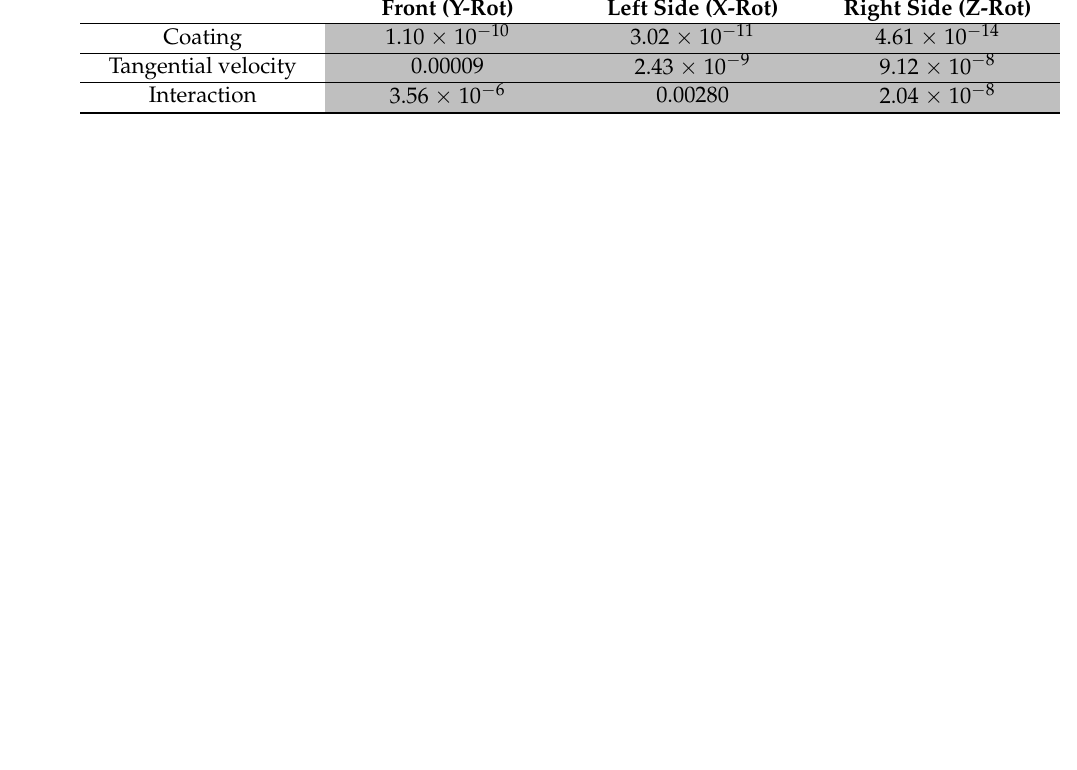
Table 8. Two-way ANOVA results ( p -values) for the PAA. p -values < 0.05 portrayed as shaded cells. Front (Y-Rot) Left Side (X-Rot) Right Side